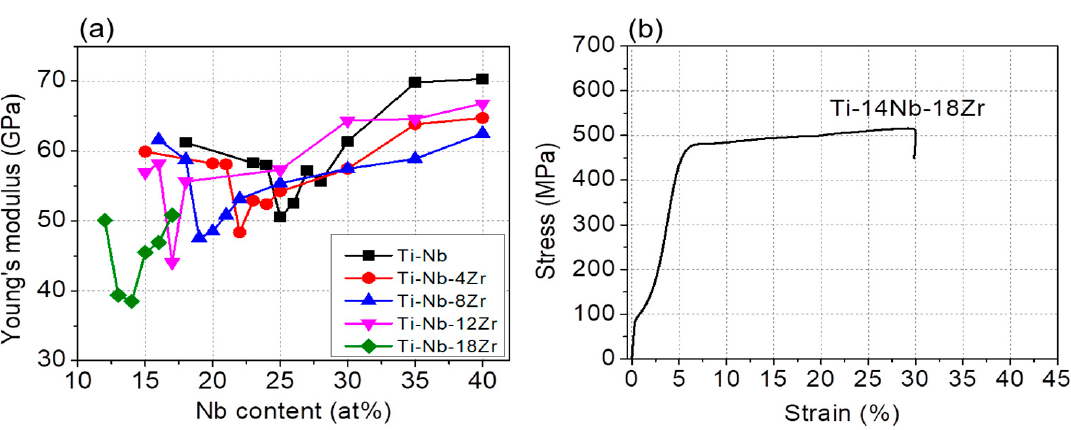
Figure 10. ( a ) Nb content dependence of the Young’s modulus for Ti–Nb and Ti–Nb–Zr alloys, and ( b ) stress-strain curve of